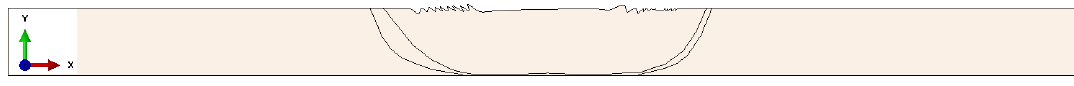
Figure 2. Typical schematic diagram appearance of the sectioned friction stir welded specimen.